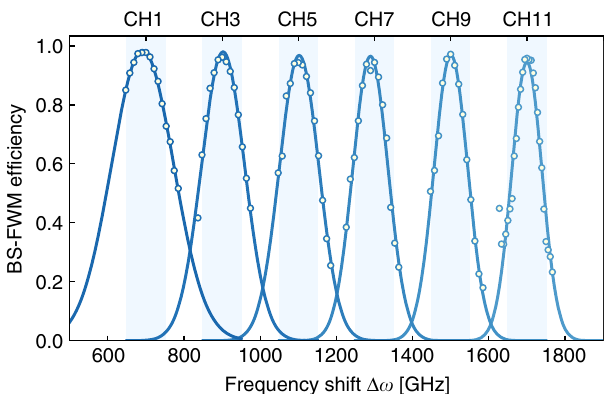
Fig. 5 Bragg scattering four-wave mixing (BS-FWM) scaling: measured BS- FWM ef fi ciency for frequency shifts Δω between the input and target frequency varying from 700 GHz (CH1) to 1700 GHz (CH11). One pump in the BS-FWM interaction is tuned in steps of 200 GHz to increase the frequency shift between the input and target frequency. The other pump is detuned by a small amount (<10 GHz) such that phase matching remains optimal at the target frequency ω t at 1284.45nm. The frequency conversion ef fi ciency is maintained at 95%, while the acceptance bandwidth is reduced by a factor of 2 due to effects of higher order dispersion. Assuming a 100 GHz channel bandwidth, this corresponds to ef fi cient conversion over